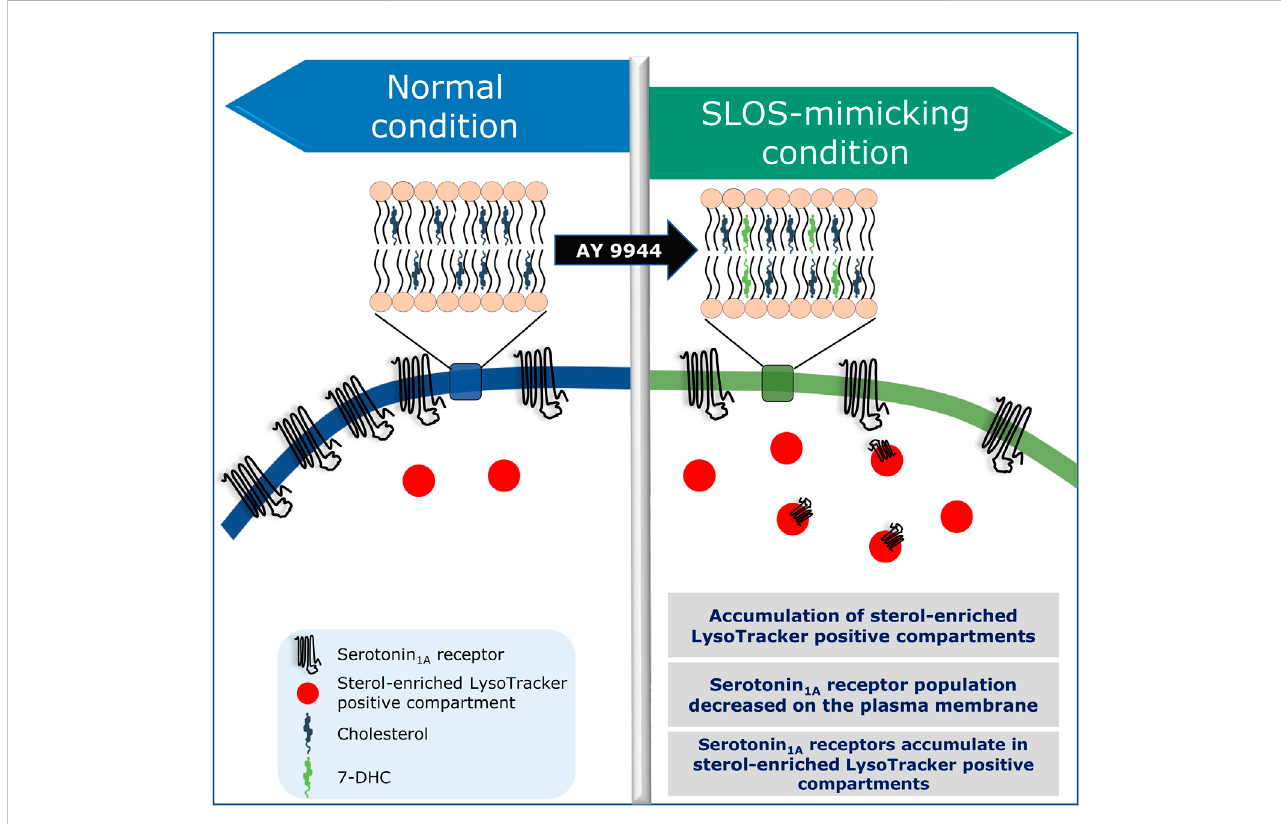
FIGURE 6 Is SLOS a traf fi cking disorder? A schematic representation showing altered localization and traf fi cking defects of the serotonin 1A receptor in a cellular model of SLOS. Adapted and modi fi ed with permission from Sharma et al., 2021. See text for more details.